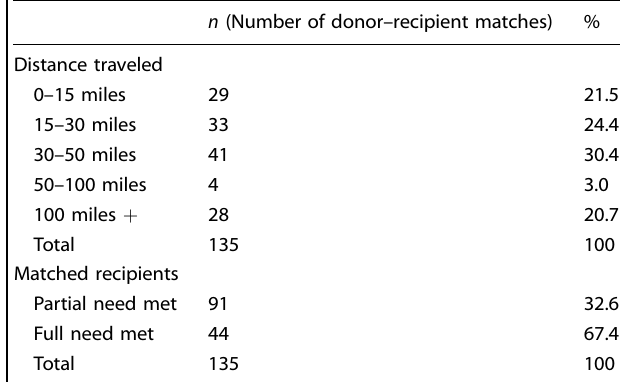
Table 2. Algorithm